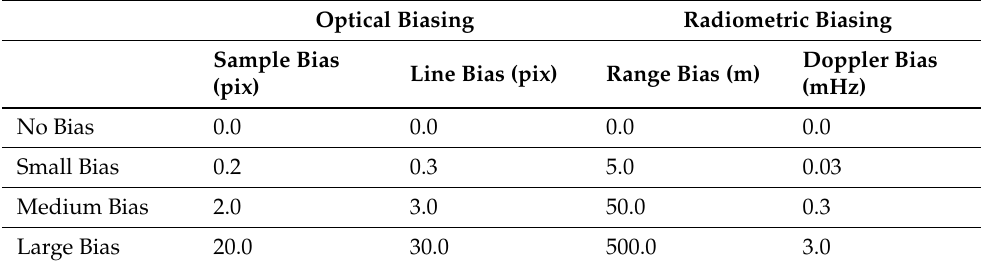
Table 2. Measurement Biasing Used in